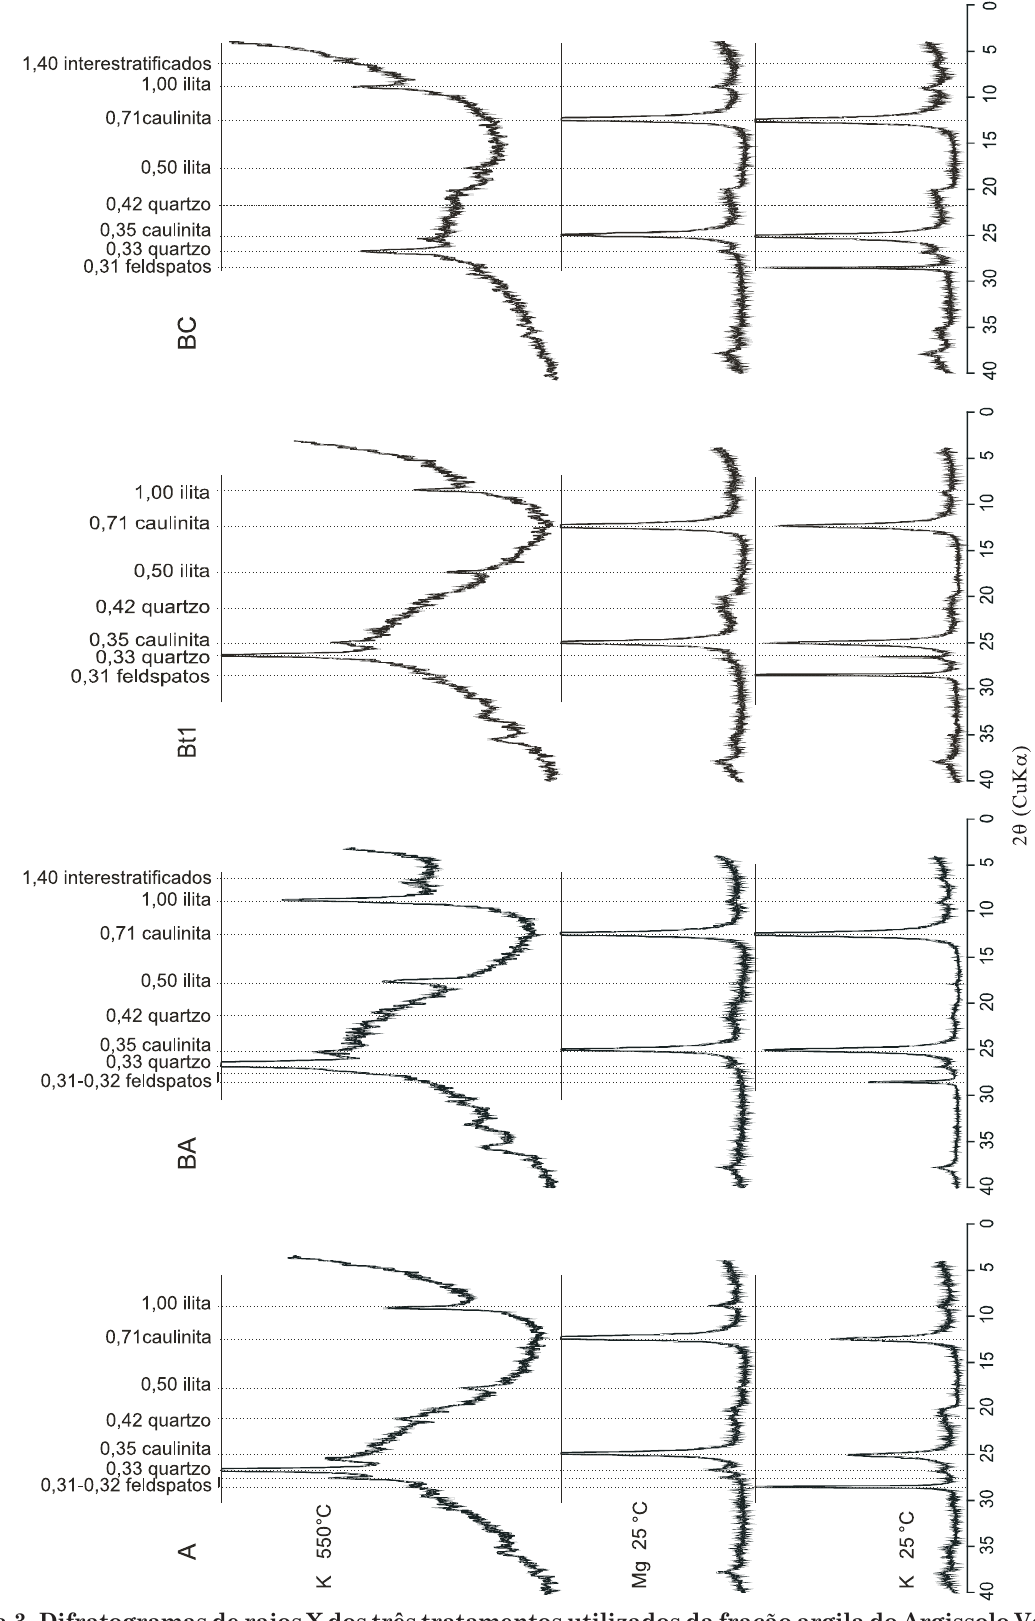
Figura 3. Difratogramas de raios X dos três tratamentos utilizados da fração argila do Argissolo Vermelho- Amarelo (horizontes A, BA, Bt1 e